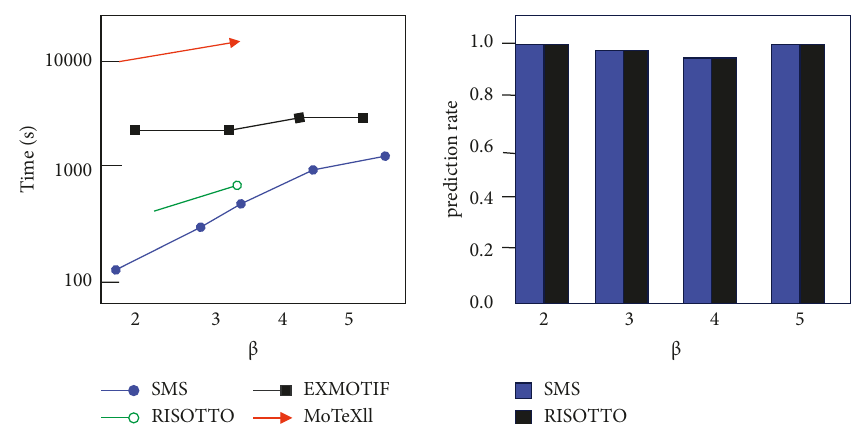
Figure 8: Experimental results on different β